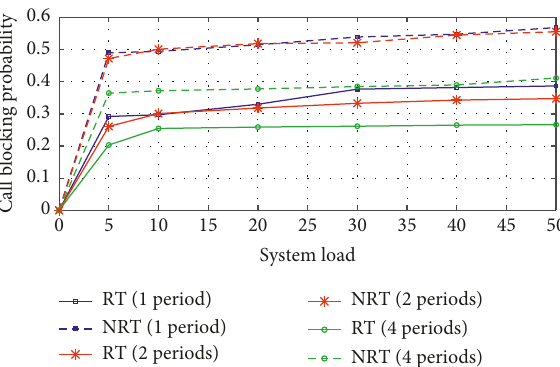
Figure 4: Call blocking probability (widespread